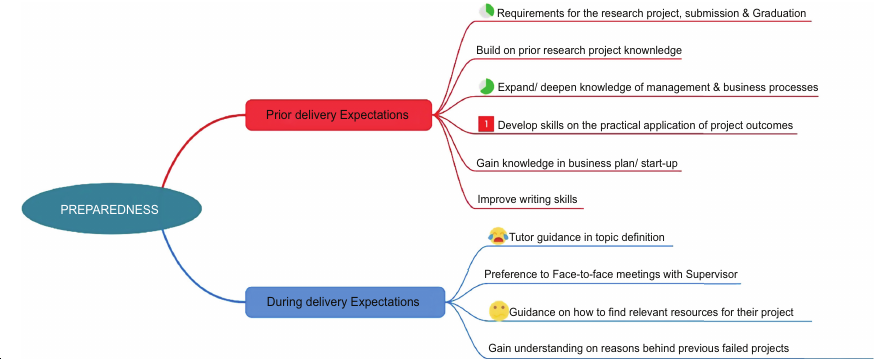
Figure 2. Interview